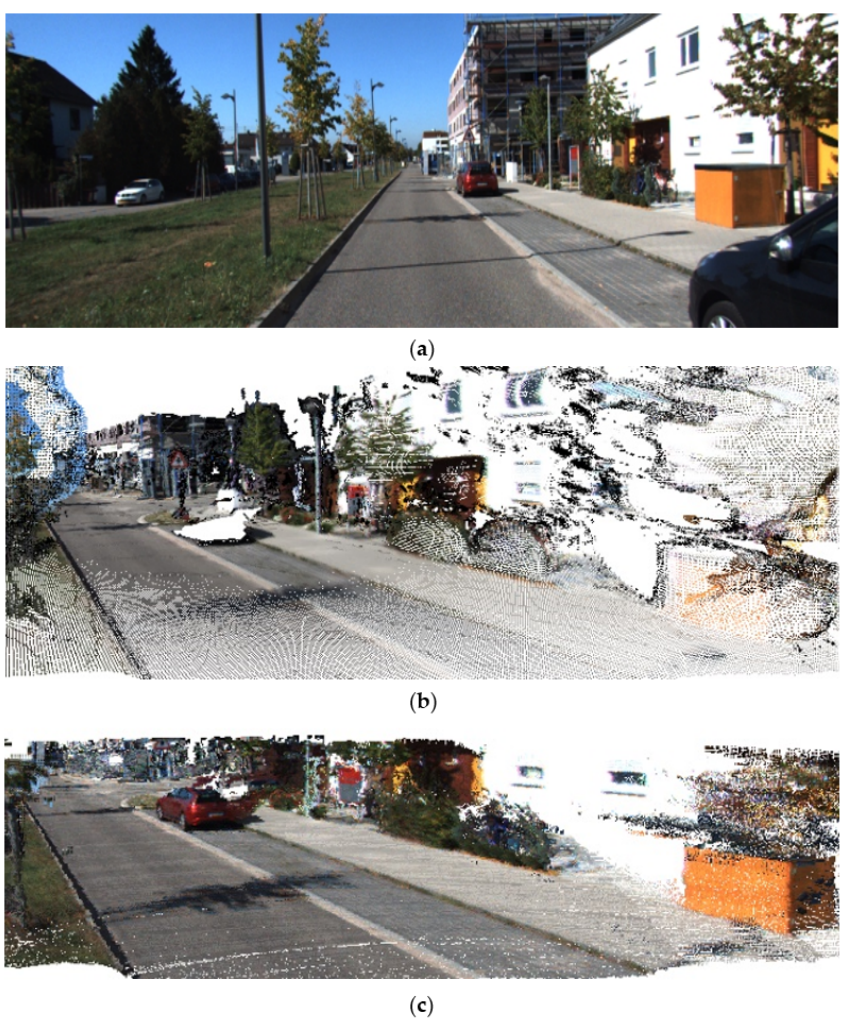
Figure 10. Reconstruction quality of different algorithms compared to raw image: ( a ) Original image of the sequence 06. ( b ) Reconstruction of our DynSLAM. ( c ) Reconstruction of our method. Sequence 00 records that the dimension is 564 m × 496 m for the urban scene. Figure